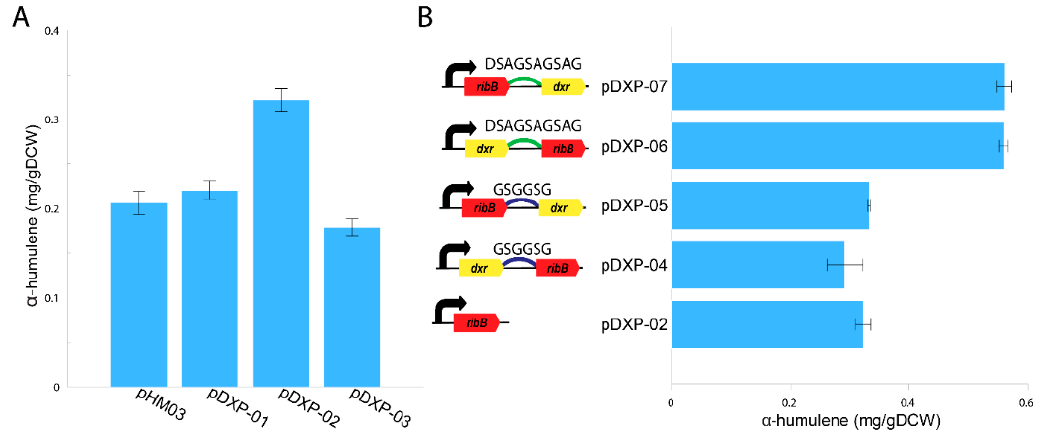
Figure 2. Production of α -humulene in the M. alcaliphilum 20Z pHM03, pDXP-01, pDXP-02, and pDXP-03 strains using methane (50% v / v ) as the sole carbon substrate ( A ). Schematic overview of the protein fusions between ribBG108S and dxr and the α -humulene production of the M. alcaliphilum 20Z pDXP-02, pDXP-04, pDXP-05, pDXP-06 and pDXP-07 strains ( B ). Analysis of α -humulene in the dodecane layer was performed, and the concentrations were compared after 96-h cultivation. The data represent the means from three replicates ± standard deviations.